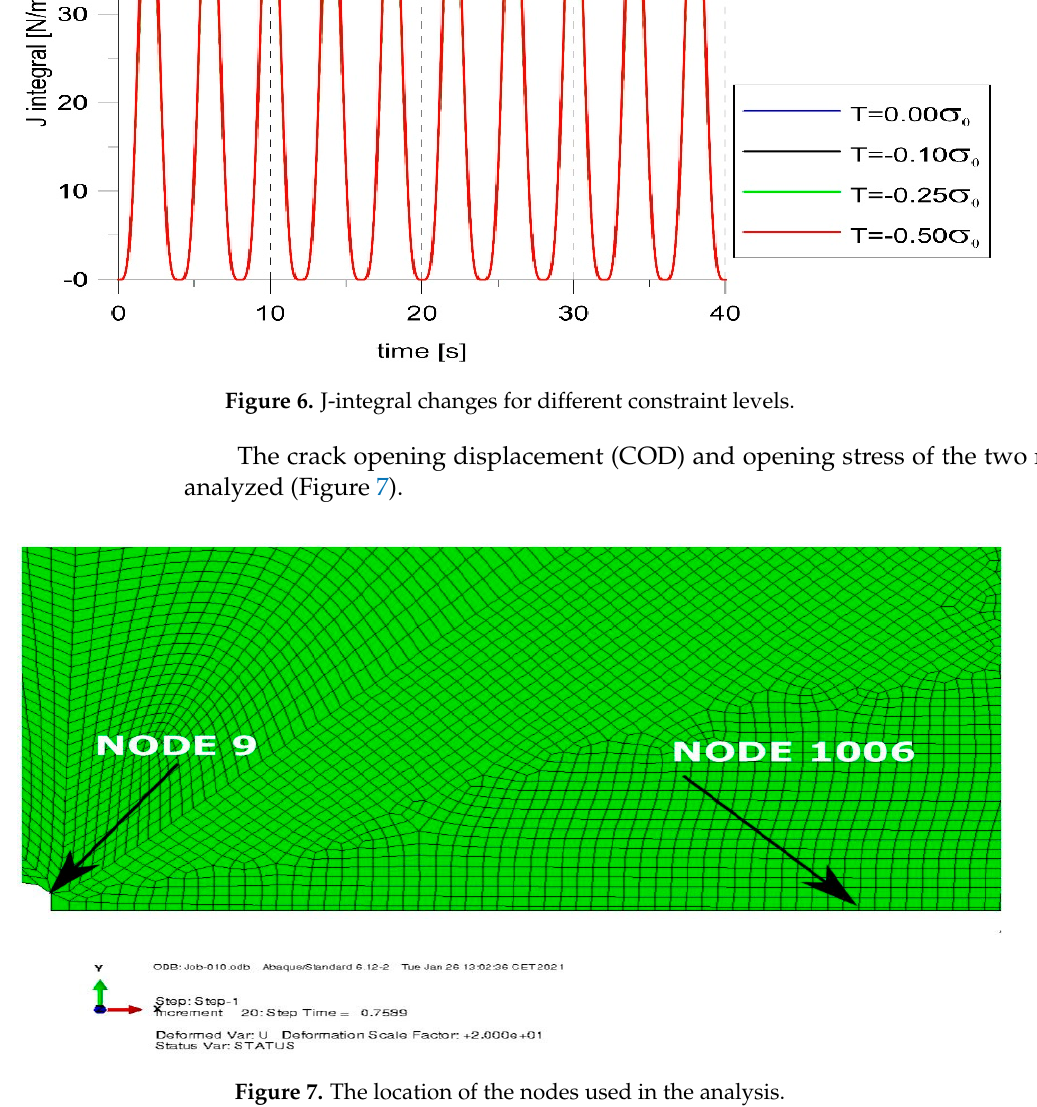
Figure 7. The location of the nodes used in the analysis. Figure 7 . The location of the nodes used in the analysis. Node number 9 lay at the initial crack tip position and node 1006 lay at the location of the crack tip for T = − 0.1 σ 0 , behind the crack tip, at the end of the simulation. In